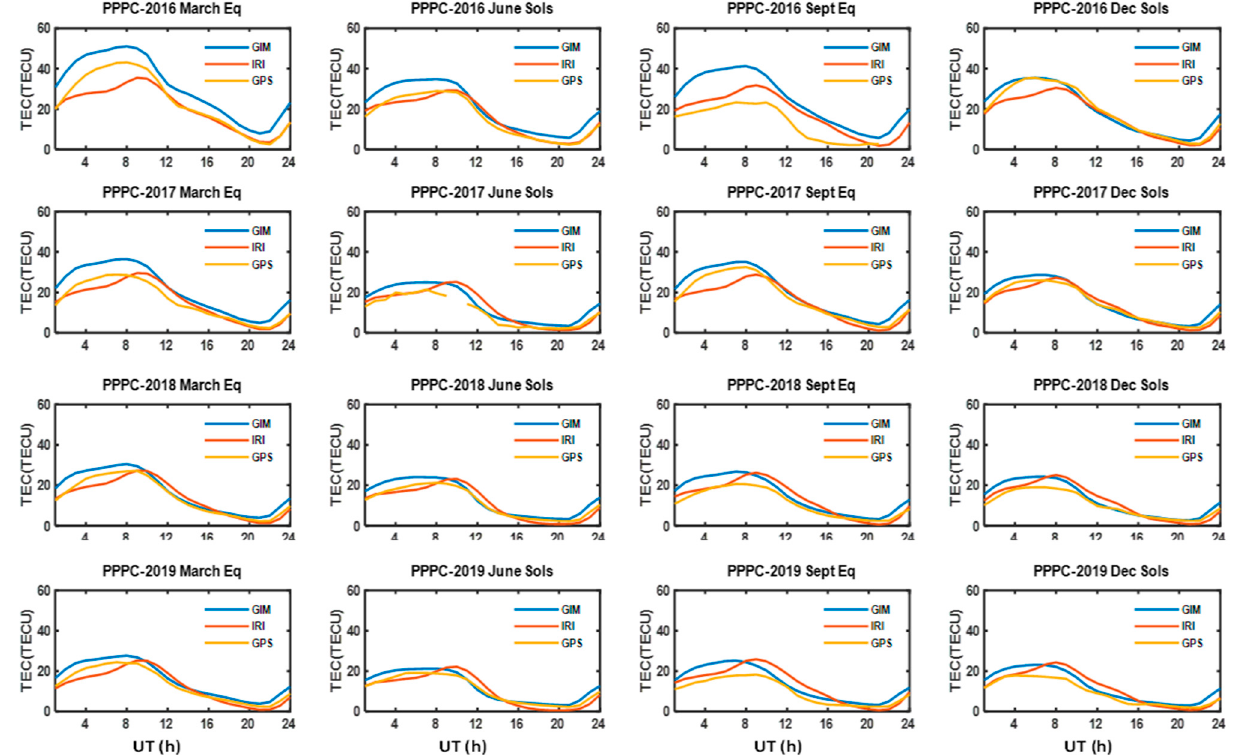
and minimum (2018–2019) phases of solar cycle 24 at HUTB.